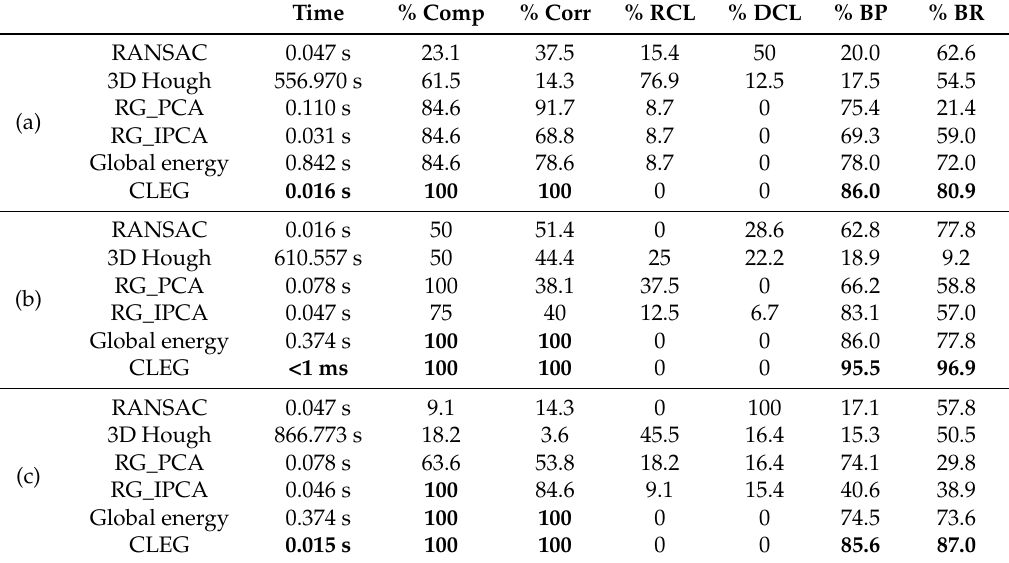
Table 5. Quality of segmentation results in the Guangzhou